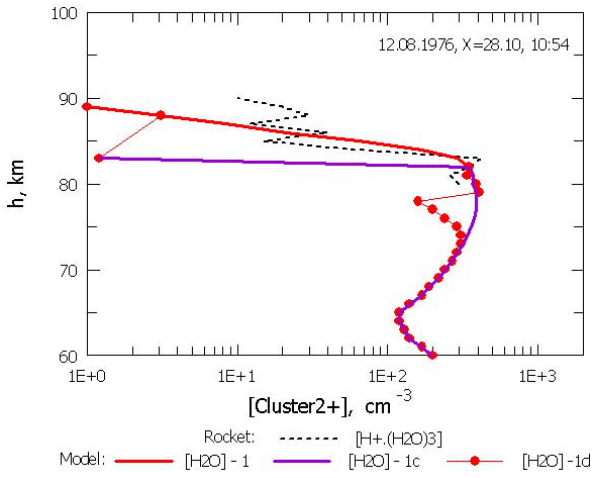
Fig. 11. Water number density profiles. The H 2 O-1 profile (red positive cluster family Fig. 10b. Number density profiles of the Cl + 2 line without symbols) was retrieved from the UARS measurements calculated for 12 August 1976 at 10:54LT, with a solar zenith angle (http://haloe.gats-inc.com/home/index.php). The H 2 O-1c (violet of 28.10 ◦ using the H 2 O-1 (red line without symbols) and H 2 O- line) and H 2 O-1d (red line with symbols) profiles are modelled for 1d (red line with symbols) profiles. The black line represents the 12 August 1976 at 10:54LT, based on the measured electron num- number density profile for H + (H 2 O) 3 proton hydrates measured by ber density shown with a black line in Fig. 8. Kopp et al. (1978).